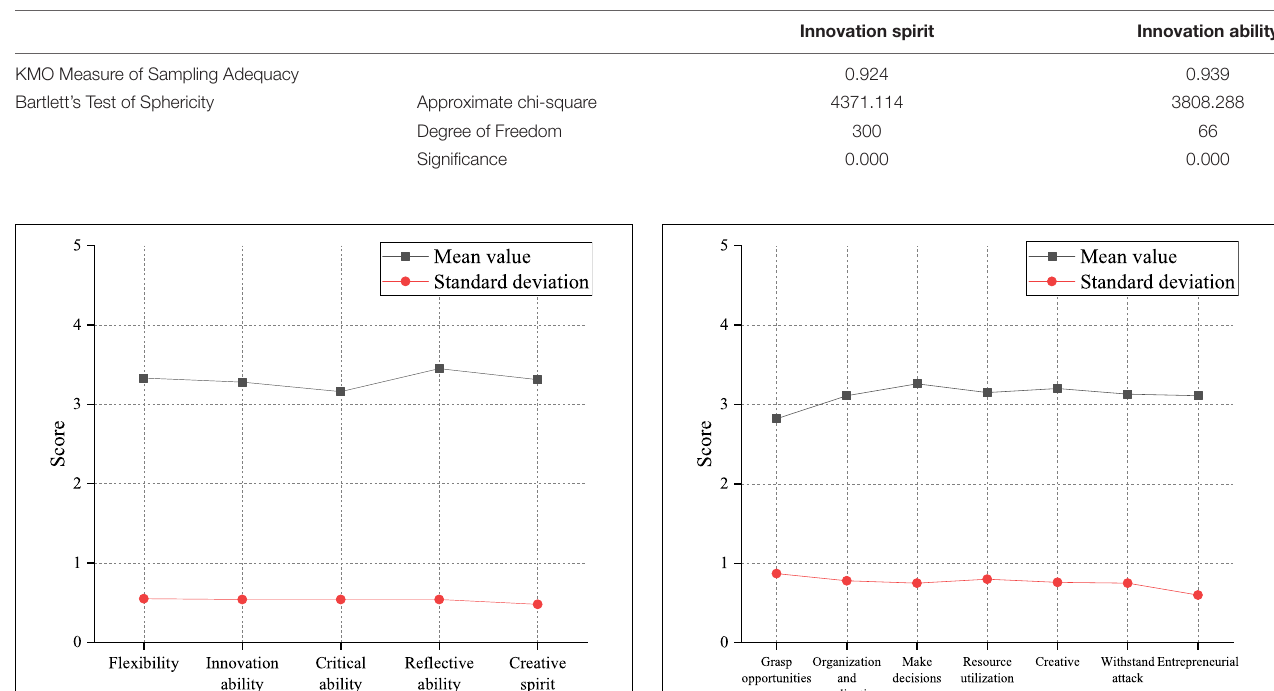
TABLE 1 | Validity analysis results.